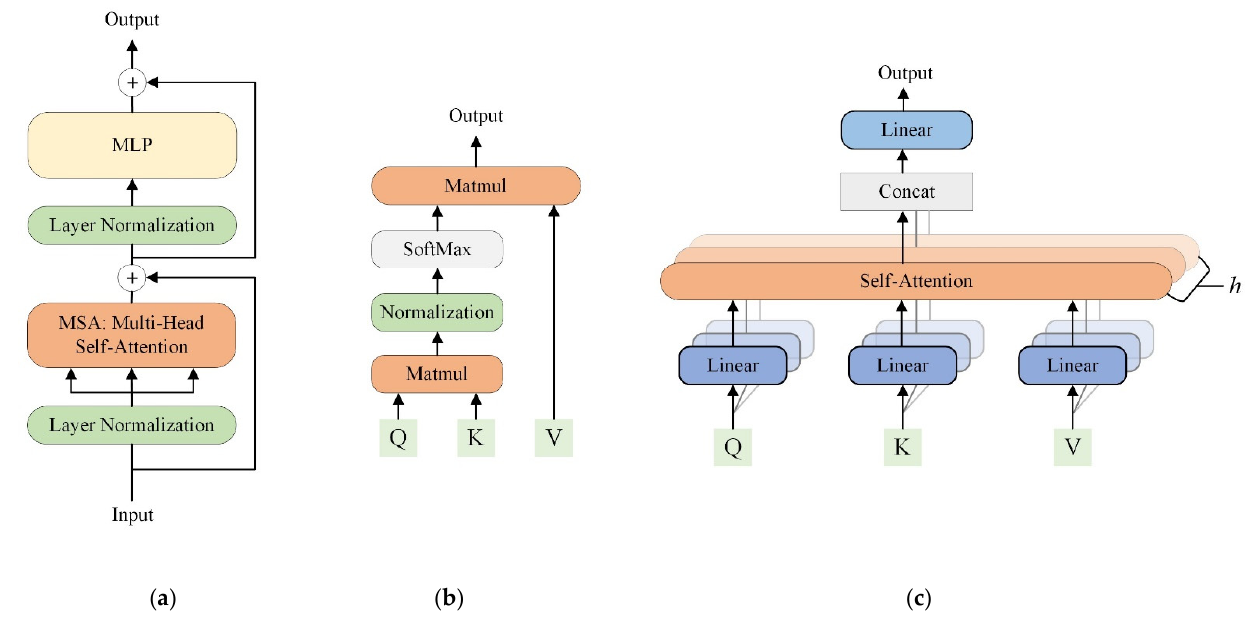
Figure 2. ( a ) The transformer block consists of an MSA, an MLP, skip connections, and layer normalizations. ( b ) Self-attention (Scaled Dot-Product Attention). Matmul: multiplication of two matrices. ( c ) Multi-head attention consists of multiple parallel self-attention heads. Concat: concatenation of feature representations. h : the number of self-attention heads.